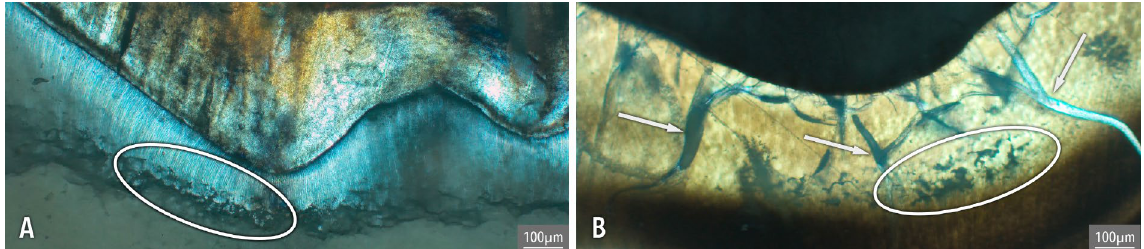
Figure 1. IGD (white ovals) in unburnt RM1 ( A ) and burnt LM1 ( B ) from B121 at approximately the same location. Note the heat-induced cracks in LM1 (see arrows).